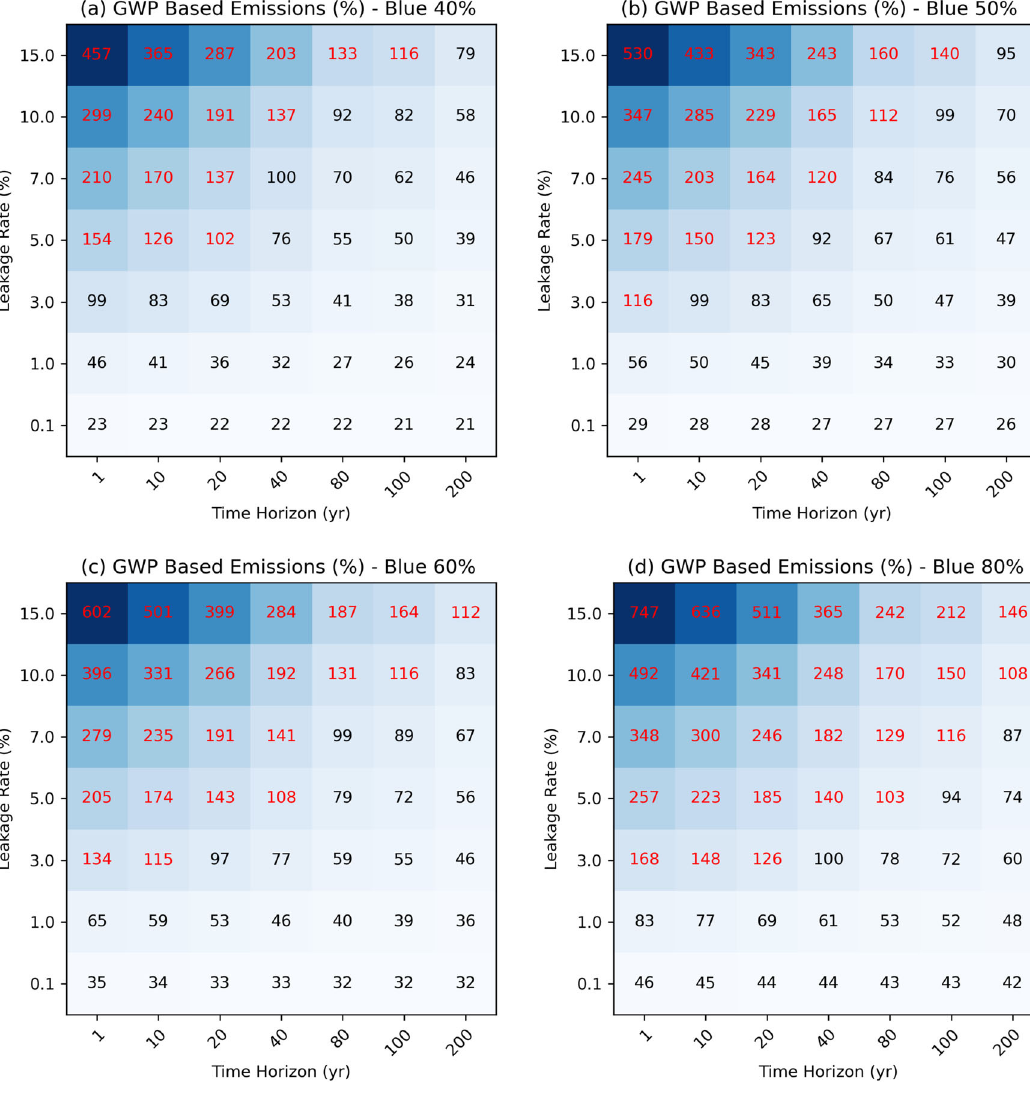
Fig. 3 Climate bene fi t of a global energy transition to hydrogen for various blue hydrogen mix. GWP based emission ratio (expressed in %) of CO 2 equivalent emissions associated with a hydrogen economy to the avoided CO 2 emissions as a function of the hydrogen leakage rate and the metric time- horizon. The emission ratios are calculated assuming a blue + green hydrogen with ( a ) 40%, ( b ) 50%, ( c ) 60%, and ( d ) 80% blue hydrogen supply. The net climate penalty conditions (ratios > 100%) are provided